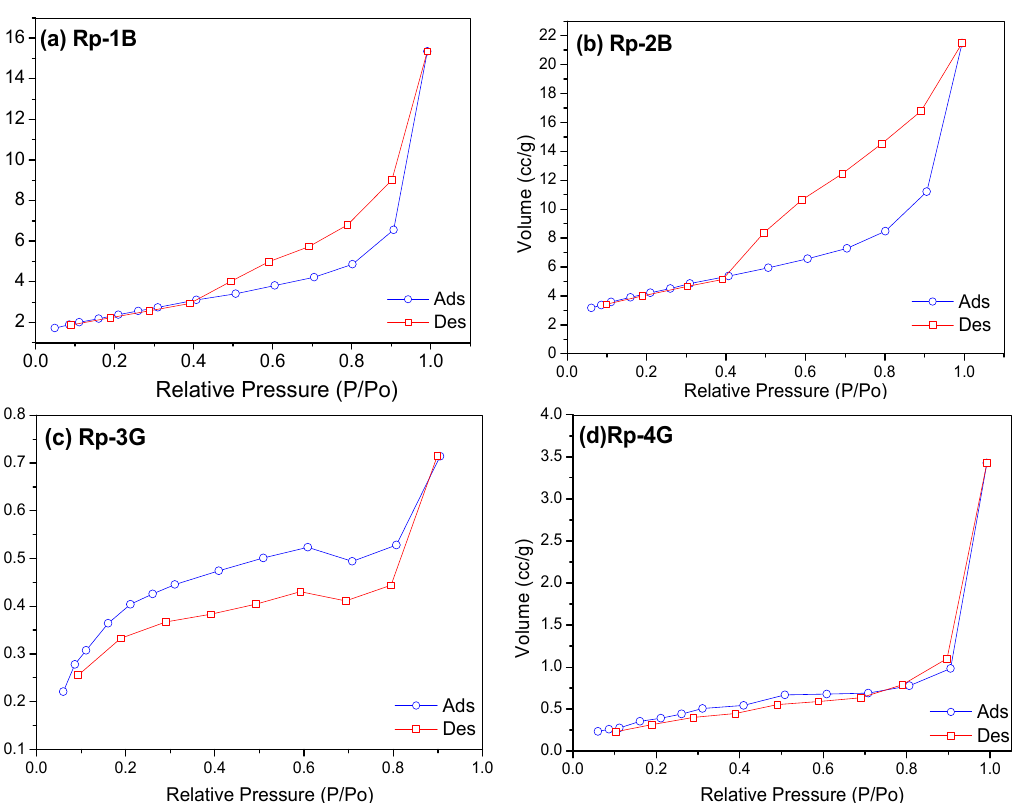
Adsorption-desorption isotherms (Figure 2) show that the four materials can be con-